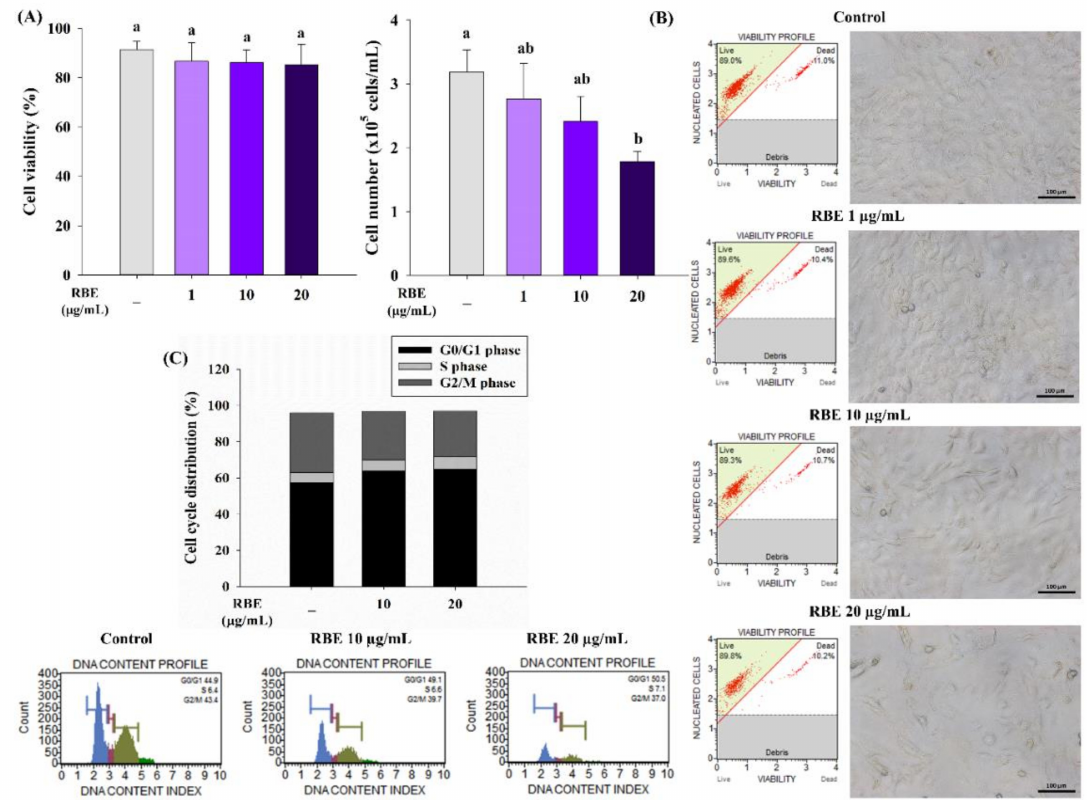
Figure 2. E ff ect of Riceberry rice extract (RBE) on 3T3-L1 preadipocyte proliferation during a 4-day period. ( A ) Treatment of cells with RBE did not a ff ect cell viability. ( B ) RBE at 20 µ g / mL significantly decreased the total cell number. Bright-field images (20 × magnification) show the reduction in preadipocyte under RBE treatment compared to the control group. ( C ) RBE at 10 and 20 µ g / mL induced cell cycle arrest with increased G0 / G1 and decreased G2 / M phases. The results are expressed as mean ± SEM from the three independent experiments. p < 0.05 for groups with di ff erent letters. Scale bars are 100 µ